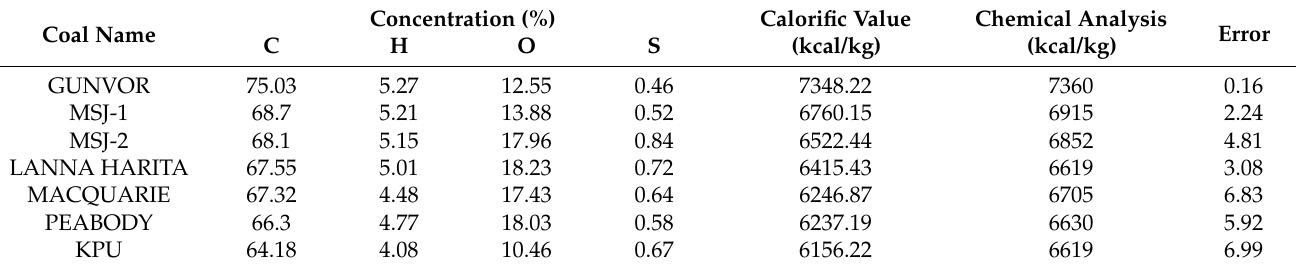
Figure 5. Sample emission spectra for ( a ) carbon, ( b ) hydrogen, ( c ) oxygen, ( d ) sulfur, and ( e ) full spectrum plot for seven coal samples. Table 2. Predicted calorific value of various coal samples by correlation